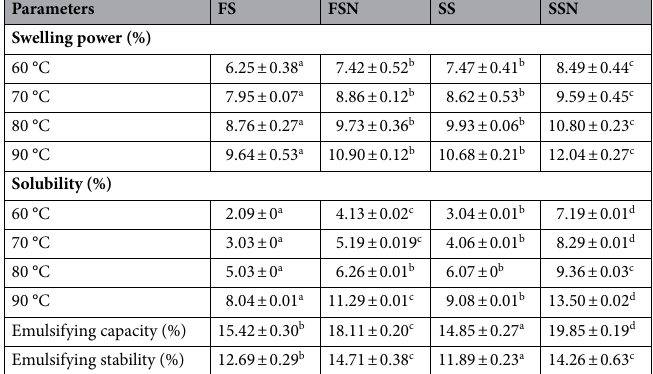
Table 3. Swelling, solubility and emulsifying properties of native and nano starch samples. FS, FSN, SS and SSN represent native foxtail millet starch, nano foxtail millet starch, native sorghum starch and nano sorghum starch, respectively. Values expressed are mean ± standard deviation. Means in the row with different superscript (a, b, c & d) are significantly different at P ≥